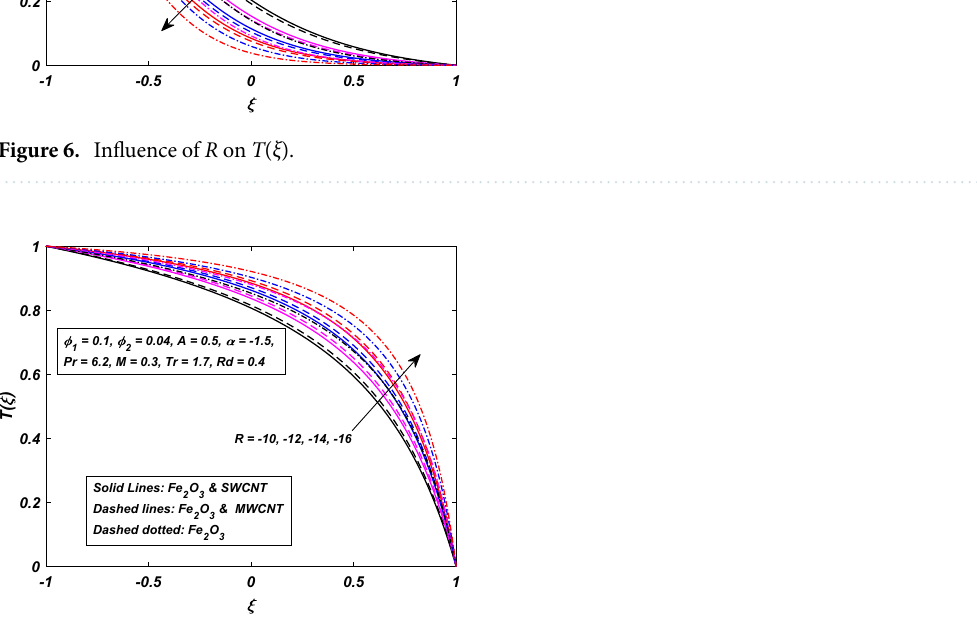
Figure 7. Influence of − R on T ( ξ